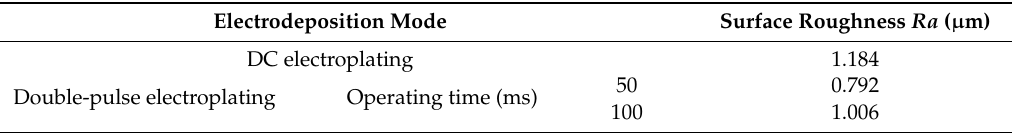
Surface roughness parameter Ra of composite coatings prepared by di ff erent electroplating modes.